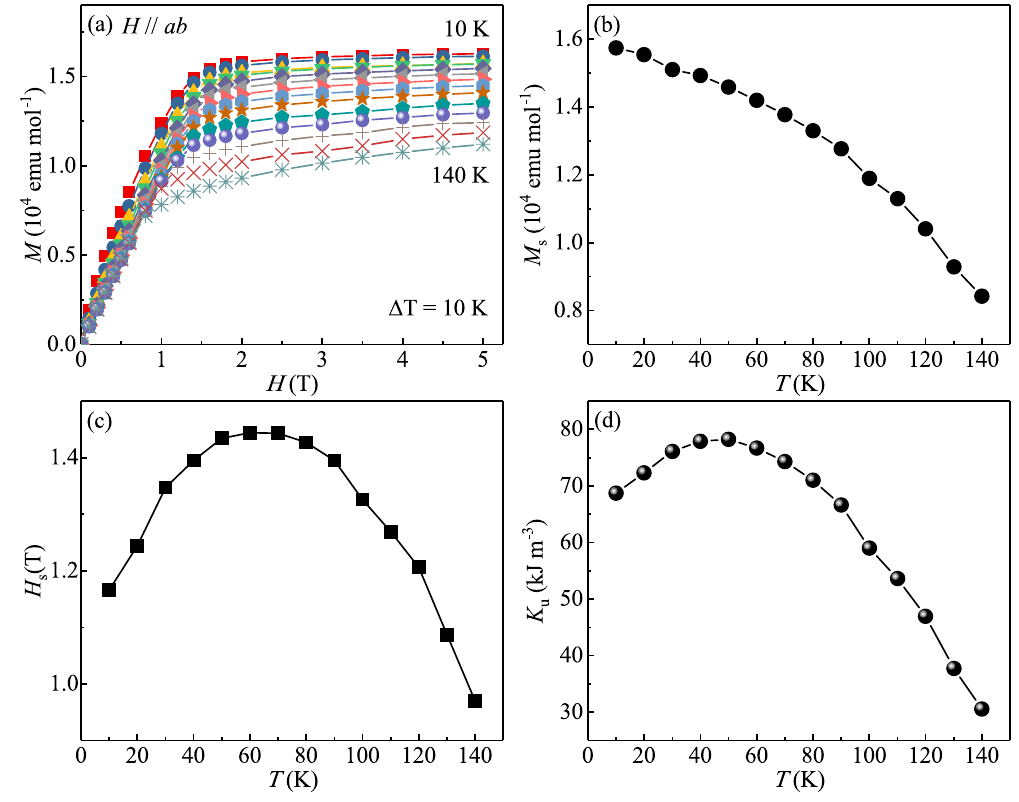
Figure 5. ( a ) Initial isothermal magnetization curves from T = 10 to 140 K with in-plane fields. Temperature evolution of ( b ) the saturation magnetization M s , ( c ) the saturation field H s , and ( d ) the anisotropy constant K u